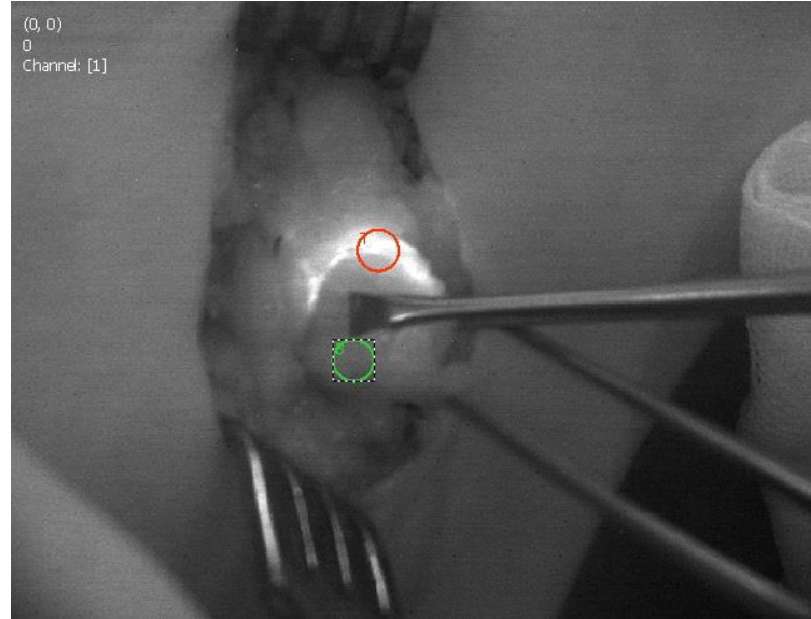
Figure 2. Sentinel node biopsy visible under fluorescence. The ROI are marked.